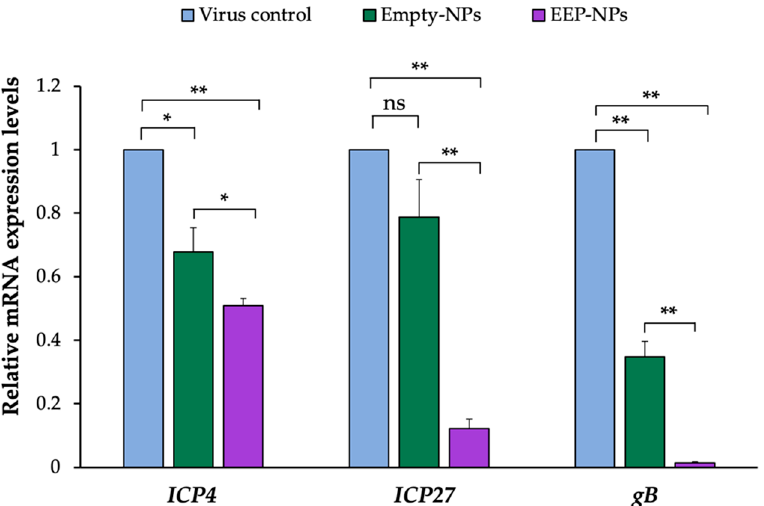
Figure 7. Effect of the EEP-NPs on the HSV-2 IE and L gene expression. The infected cells were treated with the EEP-NPs (or the Empty-NPs). The mRNA expression levels of ICP4 and ICP27 (4 h p.i.) and gB (24 h p.i.) were assessed by means of quantitative real-time PCR. Relative mRNA expression was normalized to GAPDH as the internal control, and the expression levels were represented as a fold change of 2 − ∆∆ CT compared to the virus control. Note: * p < 0.05, ** p <